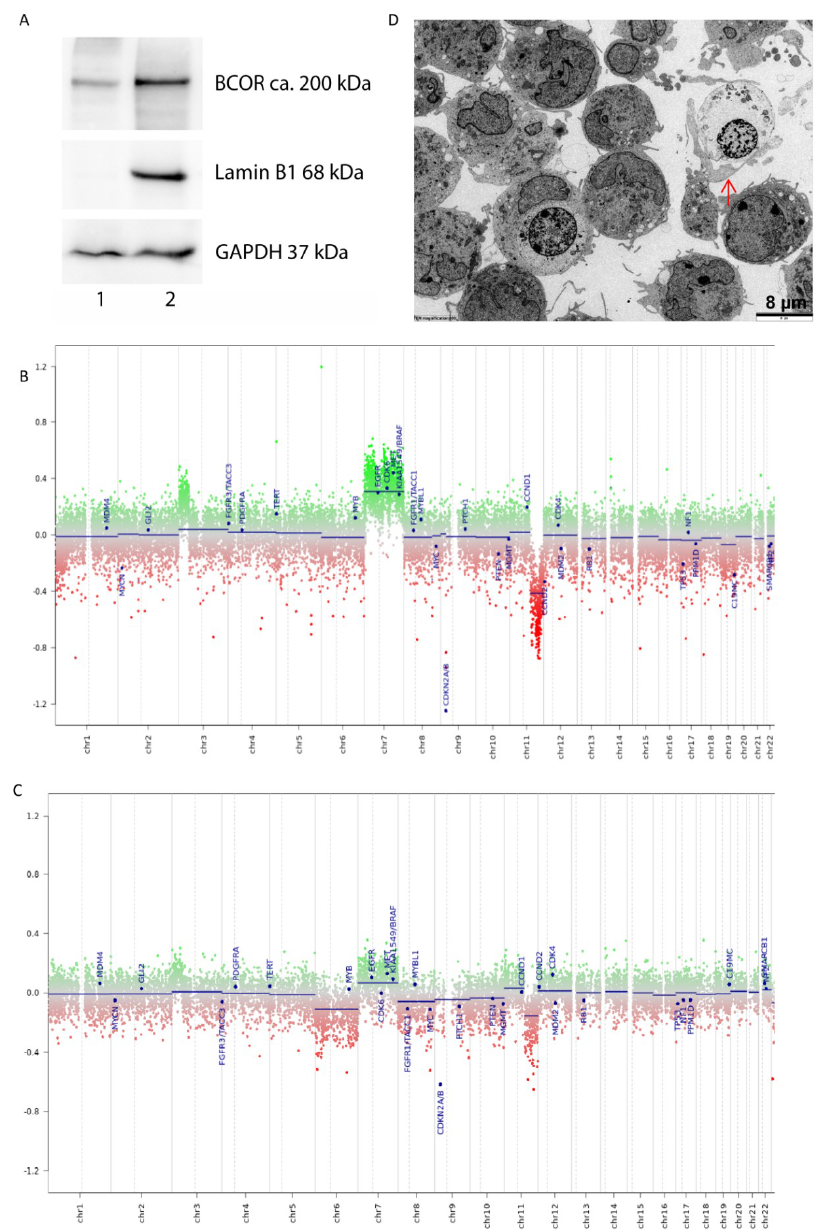
Figure 1. Characterization of a HGNET-BCOR in vitro model: ( A ) Cytosolic (lane 1) and nuclear (lane 2) subcellular components were extracted from PhKh1 cells and analyzed by western blot with a BCOR specific antibody or antibodies against different cellular compartments (Lamin B1 for nuclei, GAPDH for cytoplasm). DNA copy-number alterations of the PhKh1 cells ( B ) and of a metastasis of the HGNET-BCOR patient P1 ( C ). ( D ). Electron microscopy of the PhKh1 cells at low passage. Cells were able to form branched projections and potentially have the ability to phagocyte other cells (red arrow). EM magnification